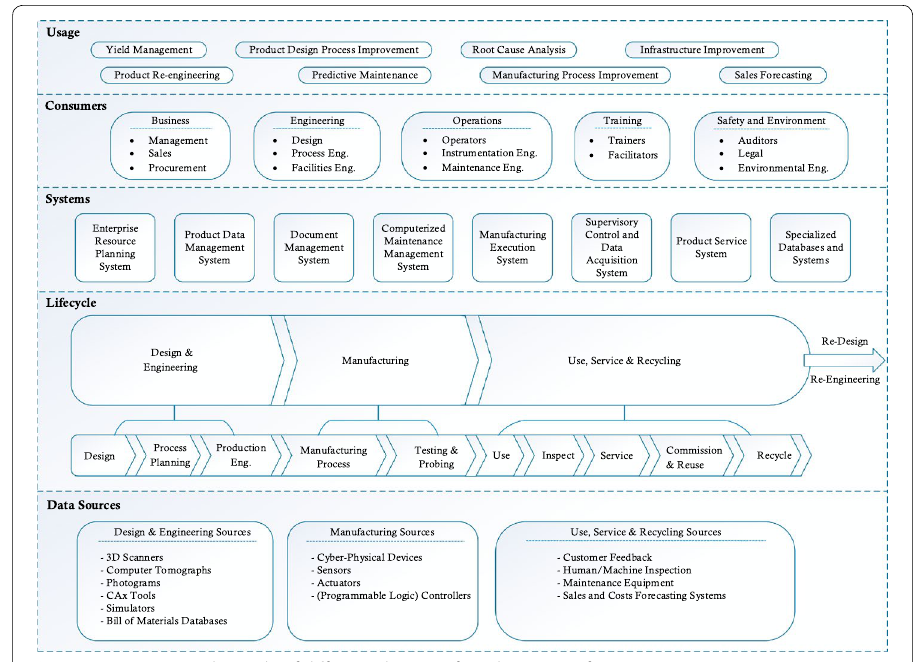
Fig. 1 A superimposed sample of different elements found in a manufacturing